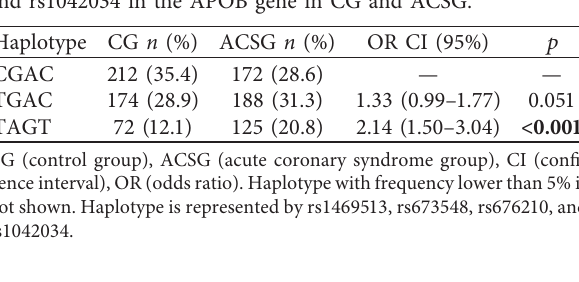
Table 6: APOB levels in ACSG adjusted by independent